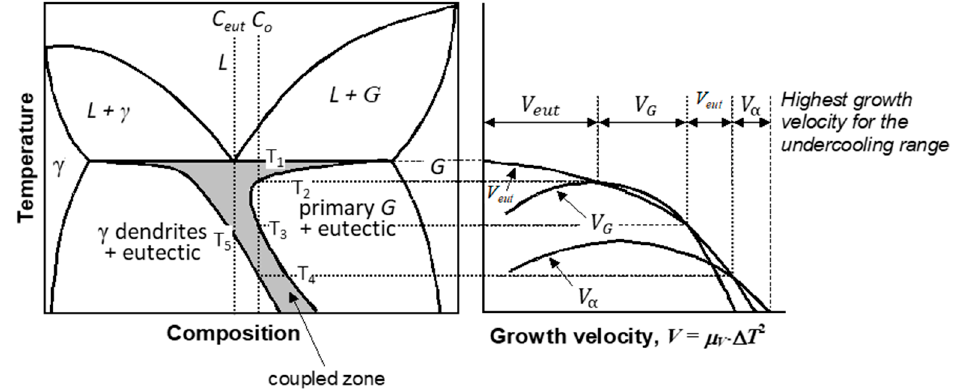
Figure 5. The asymmetric coupled zone for a eutectic alloy; adapted from [24,26]; the eutectic coupled zone is shown in grey.